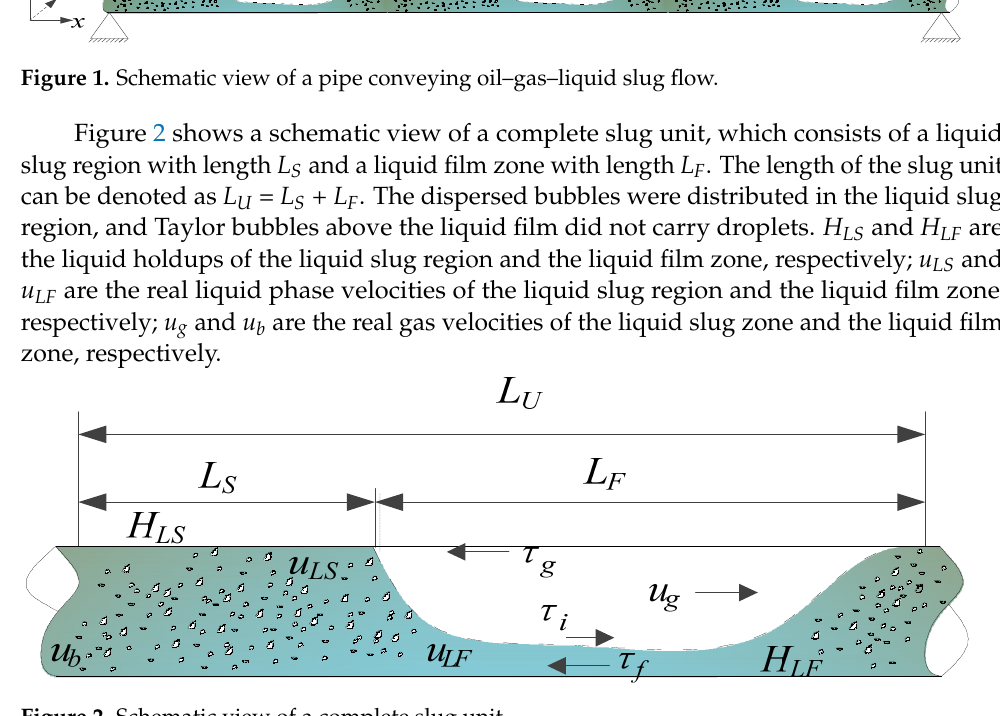
Figure 2. Schematic view of a complete slug unit.